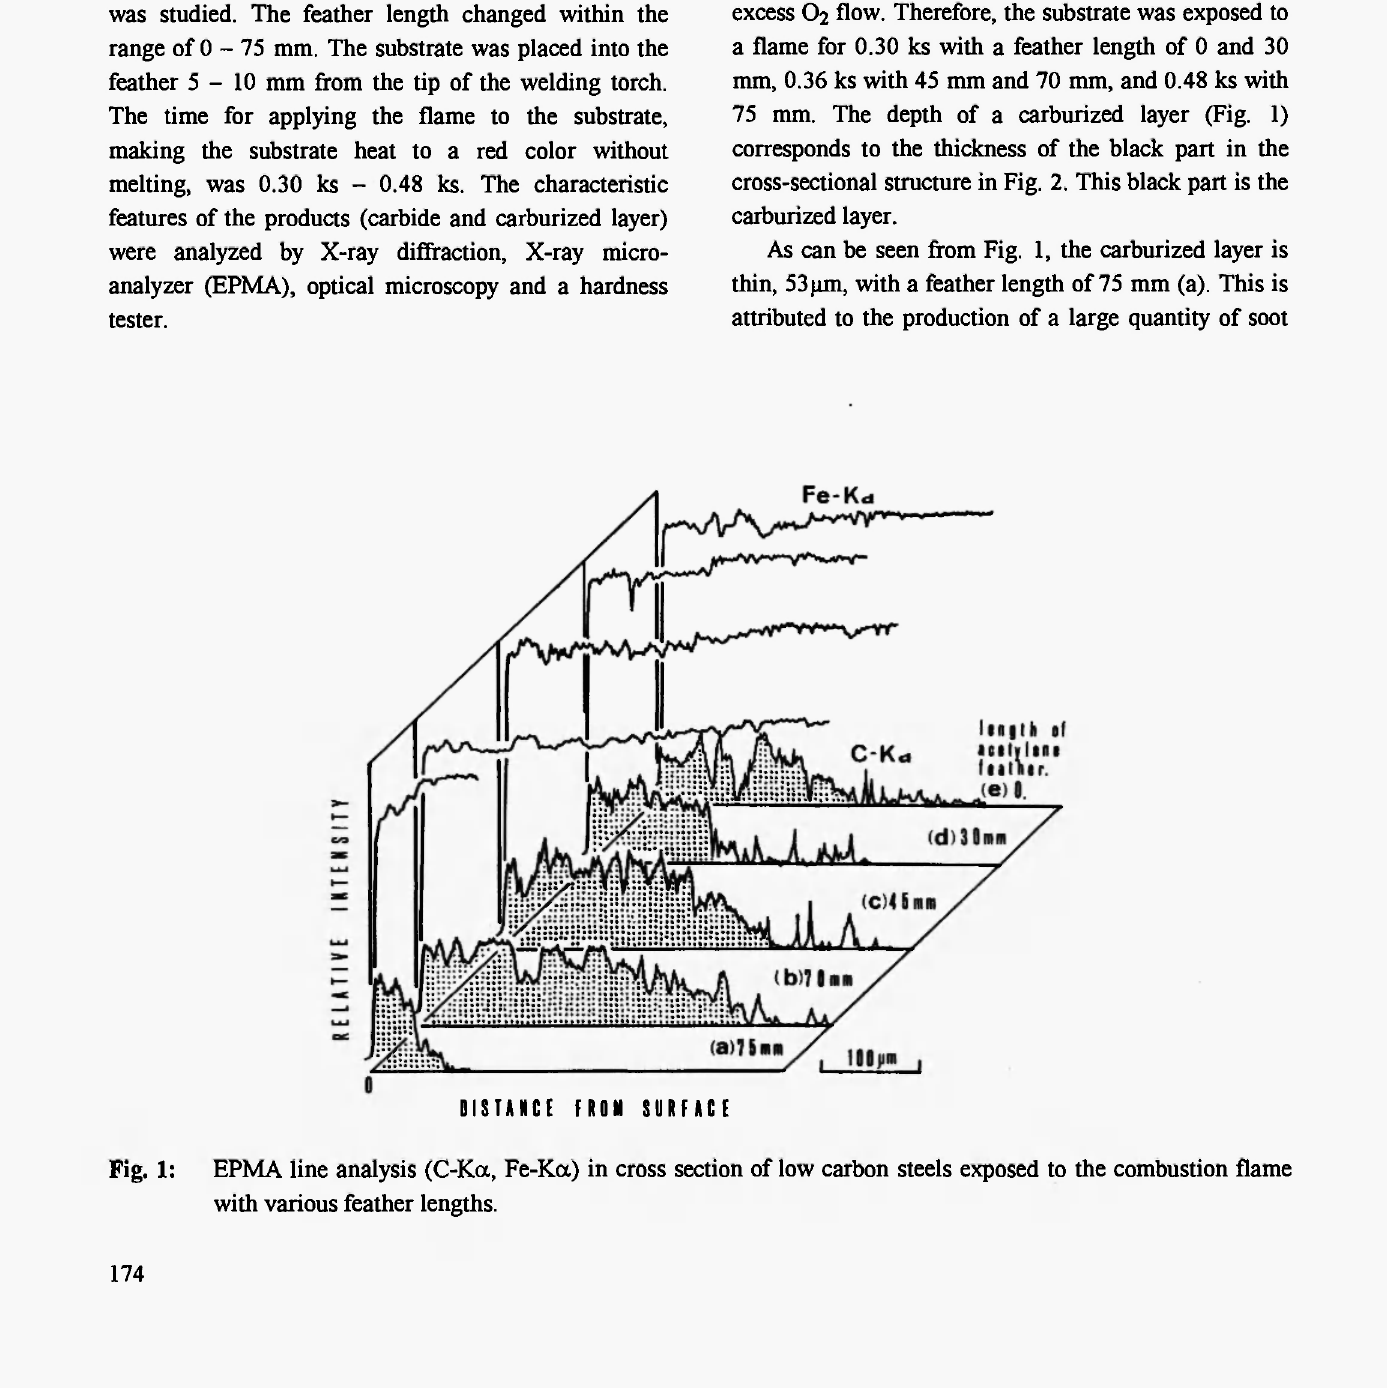
ΕΡΜΑ line analysis (C-Kcx, Fe-Κα) in cross section of low carbon steels exposed to the combustion flame with various feather